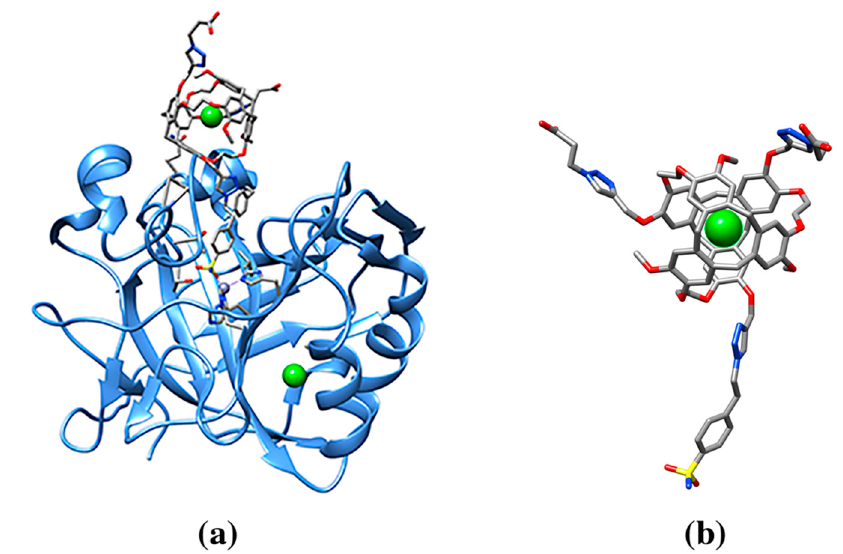
Figure 3. ( a ) Ribbon drawing of human carbonic anhydrase in complex with cryptophane-xenon (pdb entry 3cyu). The cryptophane-xenon is anchored with its benzenesulfonamide group to the zinc ion (purple) active site aromatic residues and an aspartate residue highlighted in balls-and-sticks (O red, N blue, C gray). ( b ) Cryptophane-xenon molecule (Xe green sphere, ligand cif code 0CR, or its enantiomeric molecule cif code 1CR).